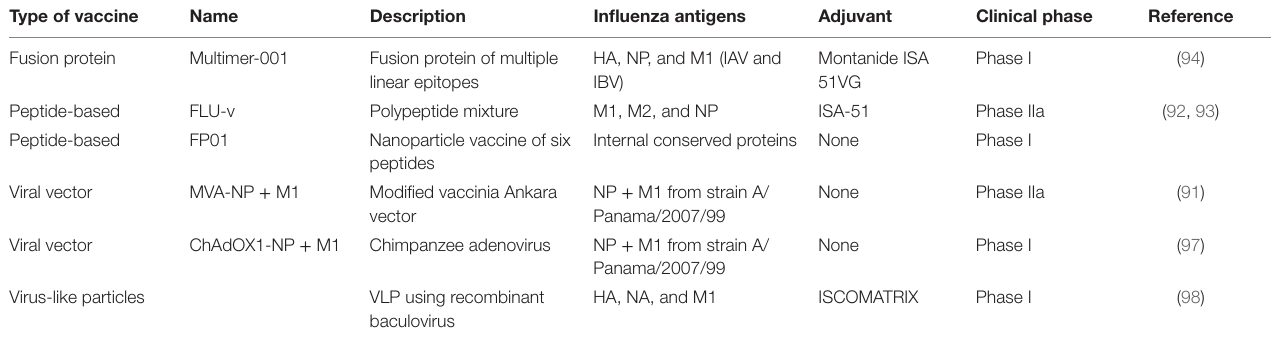
TABLe 2 | Universal T-cell vaccine candidates in clinical